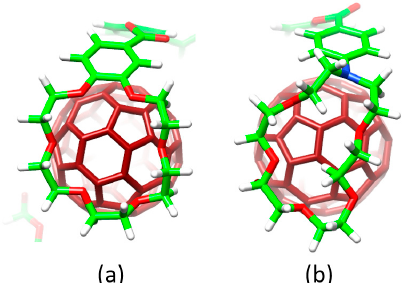
Figure 6. Side view of the B97-D/cc-pVDZ-optimized geometries calculated for complexes 2 •C 60 ( a ) and 5 •C 60 ( b ) showing the different spatial arrangement of the crown and aza-crown ethers, respectively, along the C 60 guest. The electron-acceptor C 60 is colored in red whereas the sulfur, carbon, oxygen and hydrogen atoms in the electron-donor system are colored in yellow, green, red and white, respectively.